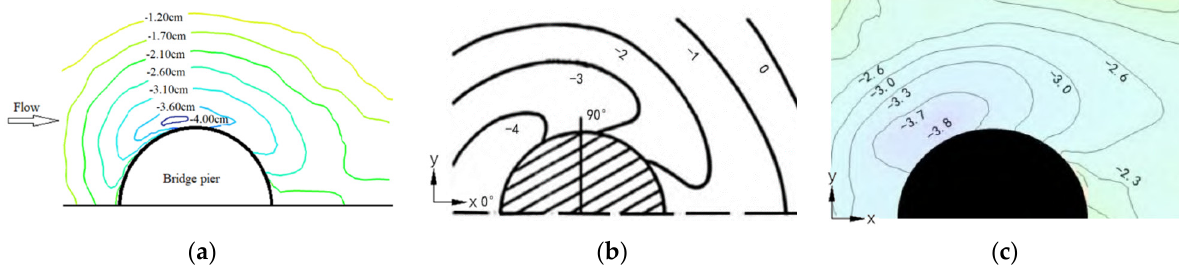
Figure 4. The contours of packed sediment net height change (unit: cm). ( a ) In this study. ( b ) Melville and Raudkivi [2]. ( c ) Zhang et al. [60].